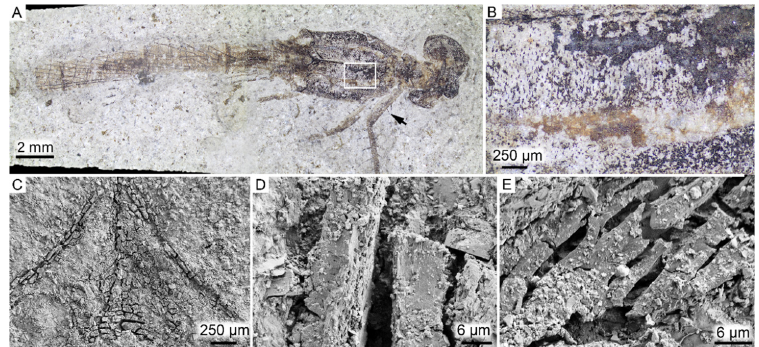
Figure 5. FUM-N-10904 (Odonata). ( A ) The fossil damselfly displayed in oblique dorsal view under conventional light. Note folded wings that rest on the abdomen, and apparent color patterns (e.g., pale shoulder stripes) on the legs and thorax. Arrow indicates location of Figure S3. ( B ) Close-up view of the area demarcated in ( A ) (upper part of the thorax) displaying black- to brown-colored matter. The latter is localized to the shoulder stripe. ( C ) SEM micrograph showing those microstruc- tures that produce the outline of the fossil. ( D ) Higher magnification SEM image of block-like cutic- ular vestiges. ( E ) SEM micrograph of inferred cuticular residues in one of the legs. Elemental data from the two specimens (Figure 6) showed that only carbon and sul- fur were concentrated to the fossil remains, although this enrichment was rather weak in the wasp. Trace elements, such as iron, occurred in low concentrations and were primarily associated with the sediment.